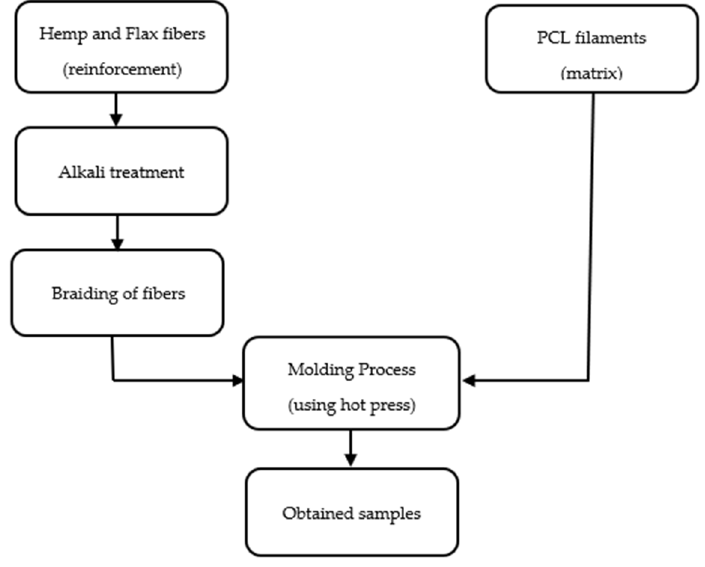
Figure 3. Flow chart for the process used in fabricating bio composites.